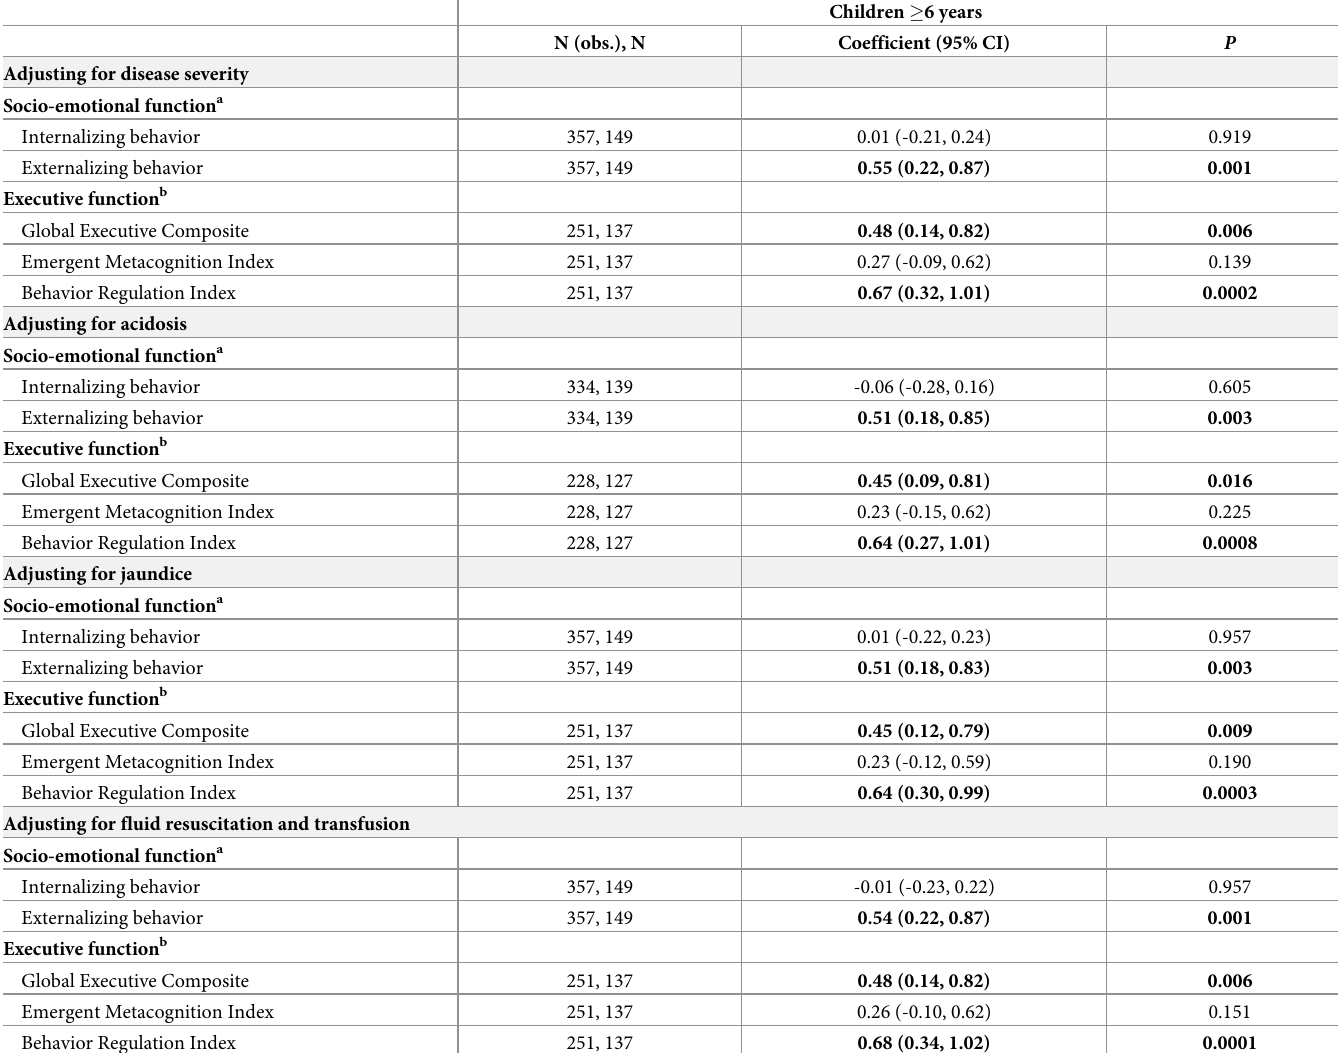
Table 4. Behavioral outcomes adjusting for severe malaria complications and